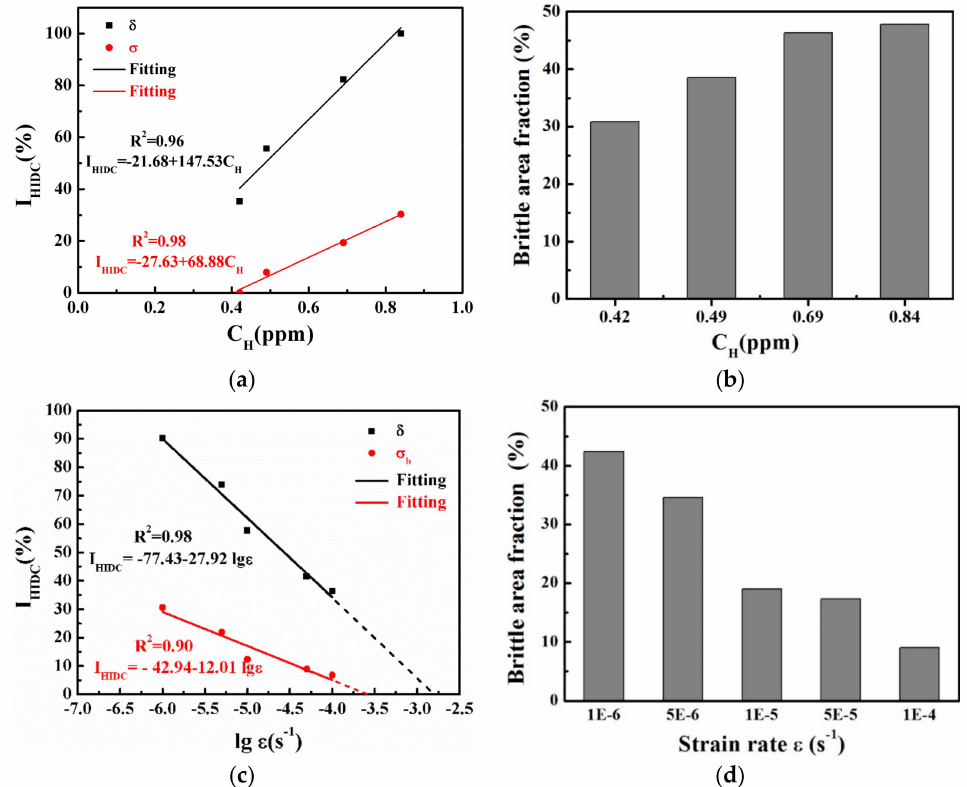
Figure 14. Relationships between ( a ) the hydrogen-induced delay cracking (HIDC) sensitivity index and hydrogen content, ( b ) the brittle area fraction and hydrogen content, ( c ) the HIDC sensitivity index and strain rate, and ( d ) the brittle area fraction and the strain